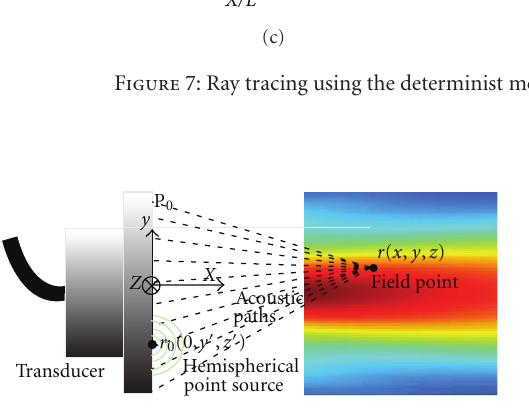
Figure 8: Ultrasonic transducer with radiating surface, in sodium acoustic beam